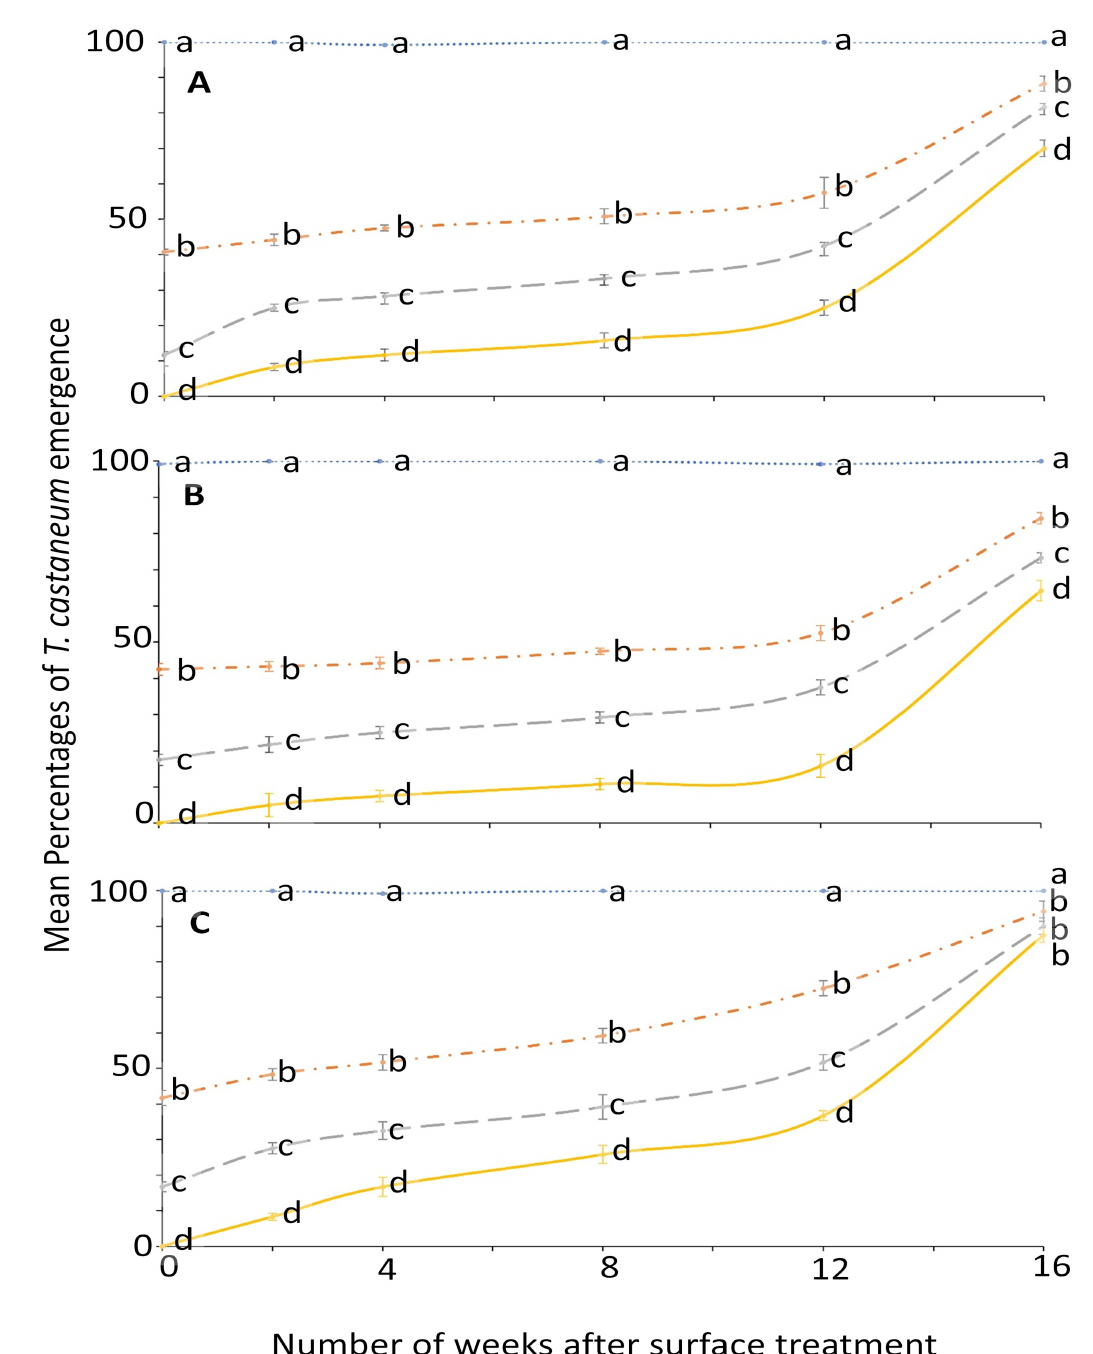
Figure 3. Mean percentages of adults emerging from last-instar T. castaneum after exposure to novaluron applied 0–16 weeks previously at concentrations of 4- (solid line), 2- (dashed line), 1- (dashed-dotted line), or 0-ppm (dotted line) onto different surfaces: ( A ) concrete; ( B ) metal; or ( C ) wood. In comparisons among mean emergence percentages from different concentrations tested on a given week after application to a specified surface, designated a–d above, means with the same letter are not significantly